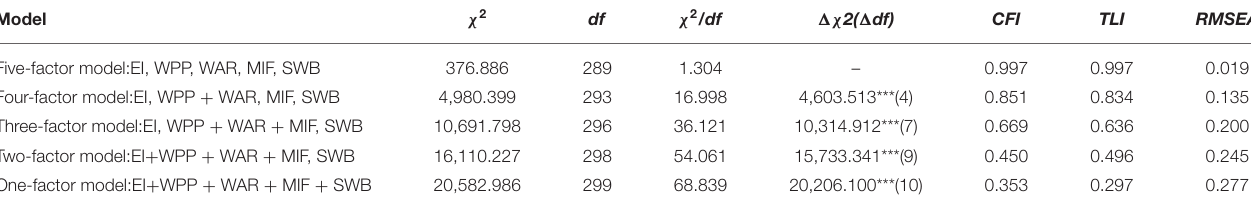
TABLE 2 | Confirmatory factory analyses.